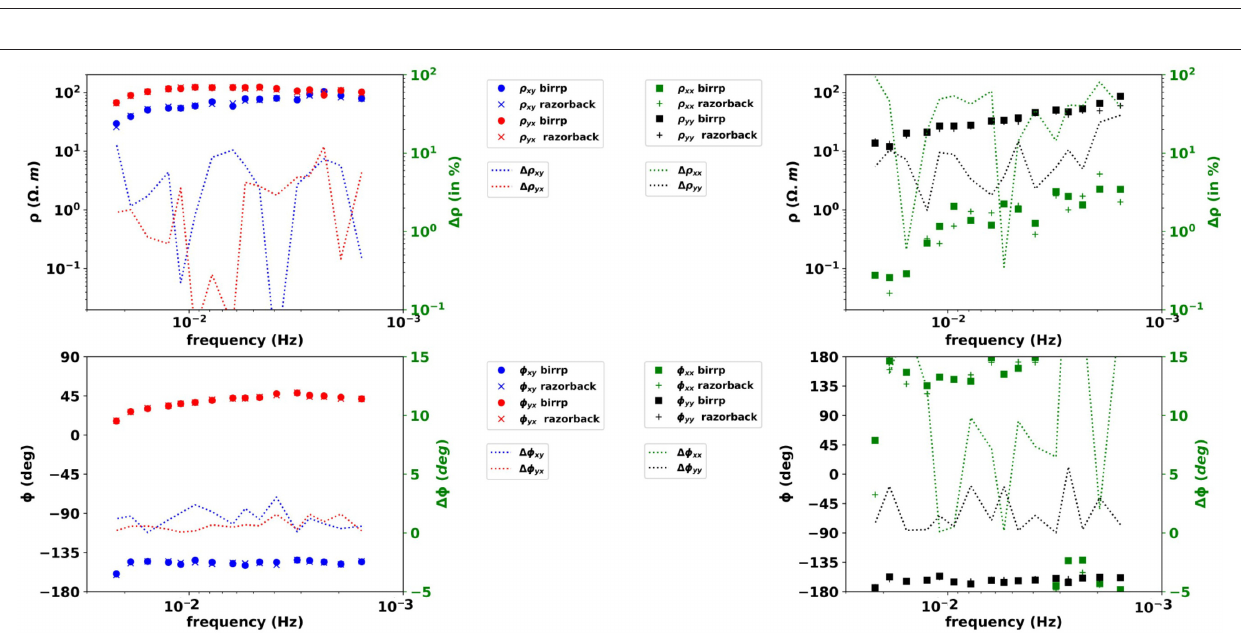
FIGURE 4 | M-estimator results in RR configuration. Same legend as Figure 2 but for RR results.